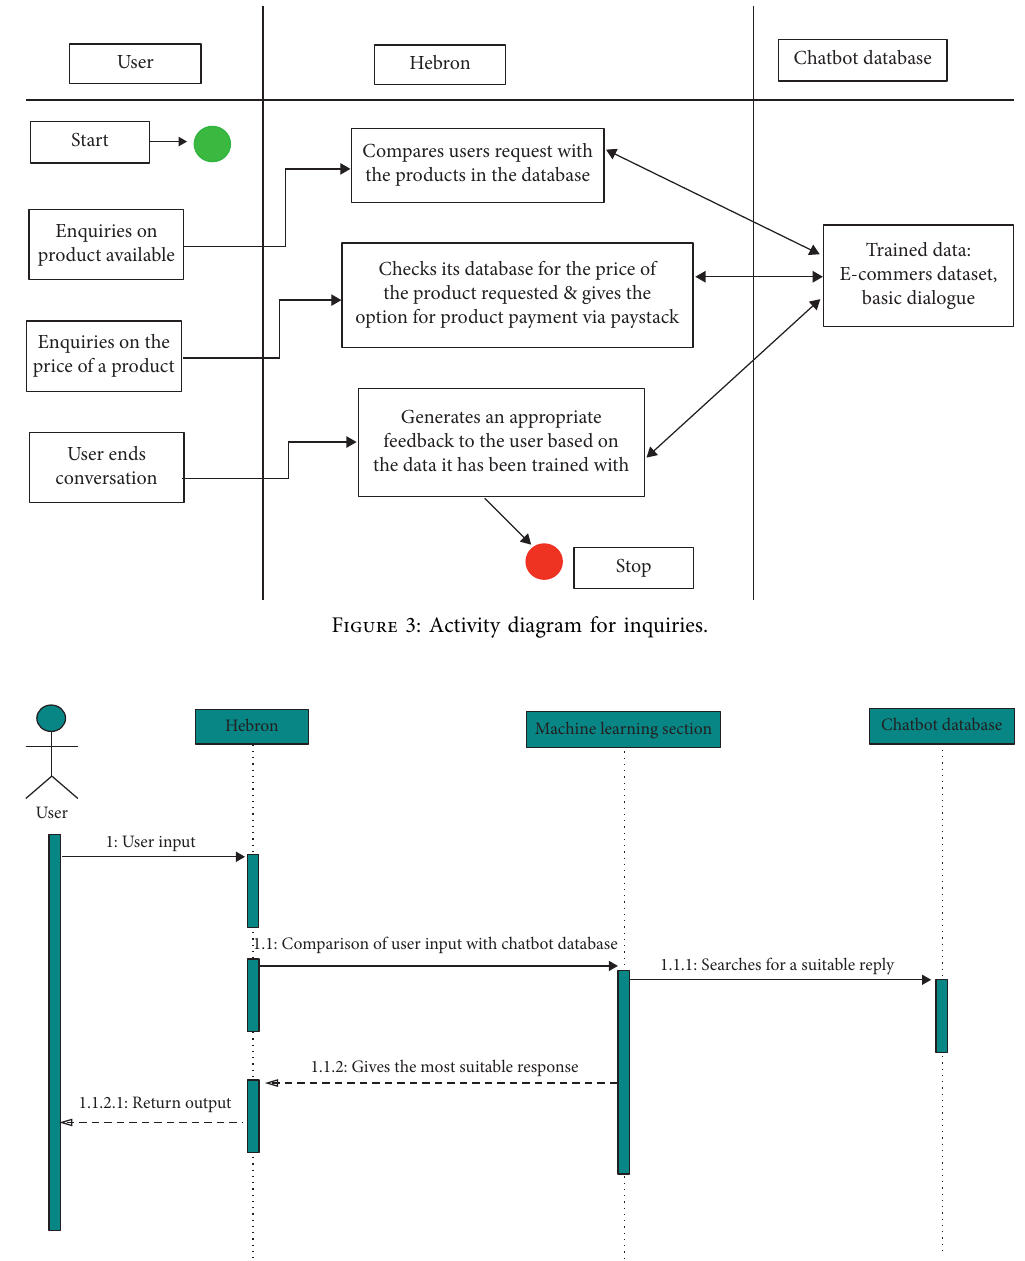
Figure 4: Overall sequence diagram for CUSM